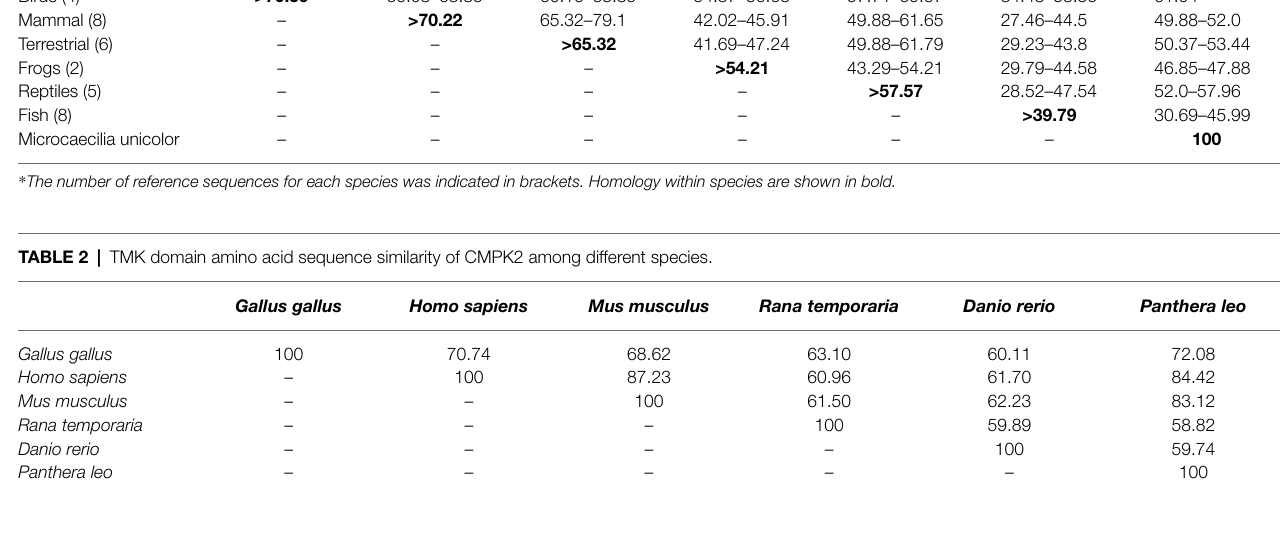
TABLE 1 | Full-length CMPK2 amino acid sequence similarity among different species.